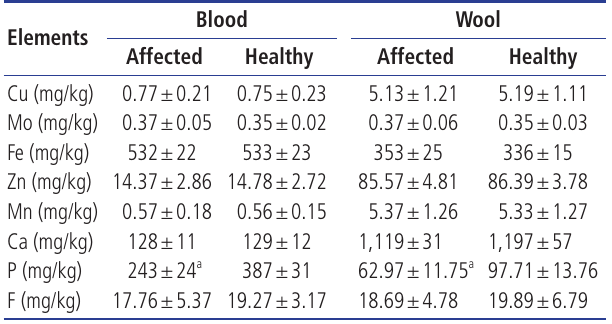
Table 5. Mineral element contents in blood and wool of Qianbei-Pockmarked goats